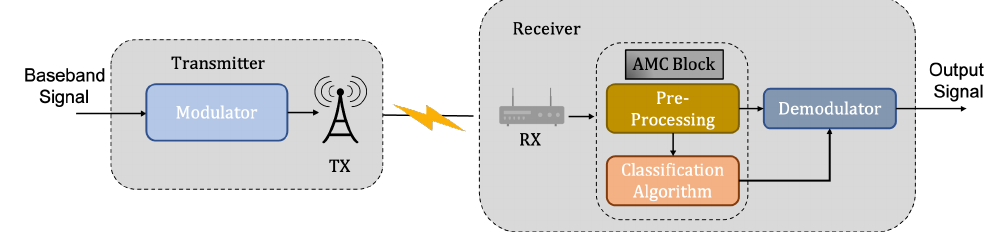
Figure 1. Block diagram of a communication link with automatic modulation